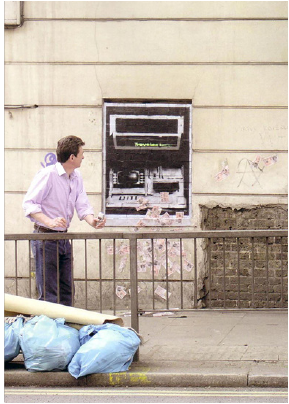
Fig. 5 Banksy, Cashpoint with Di-Faced Tenners (Banksy, 2005, p.